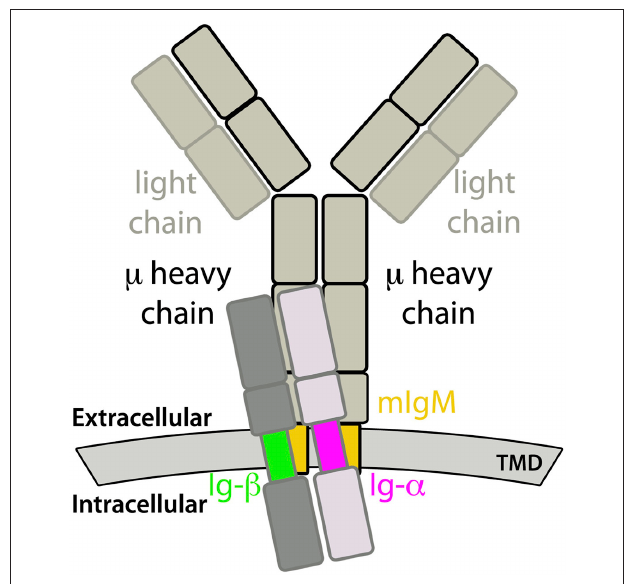
FIGURE 1 | Sketch of a IgM-B cell receptor (BCR) complex. The transmembrane domains of mIgM and the Ig- α /Ig- β heterodimer are